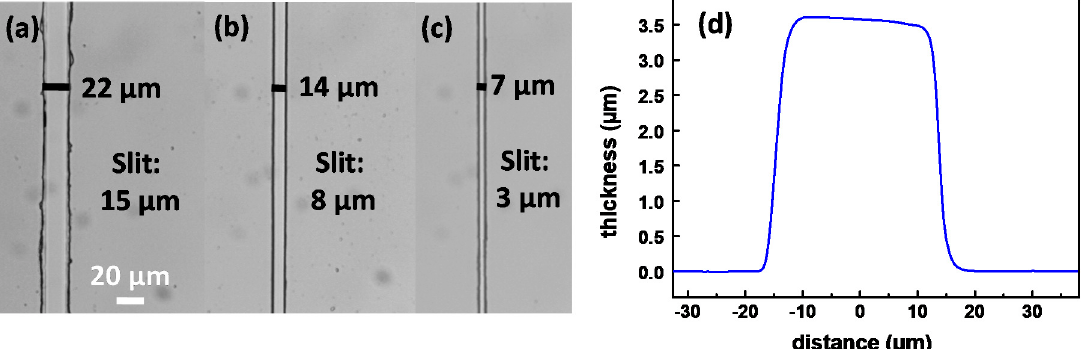
Figure 4. TiO 2 –SiO 2 patterns obtained using the amplitude mask with different slits at 15 µm, 8 µm and 3 µm. Microscope observations (reflection x20) of ( a ) line obtained with a slit of 15 µm in width, ( b ) line obtained with a slit of 8 µm and ( c ) line obtained with a slit of 3 µm. ( d ) Profilometer measurement of ( a ).